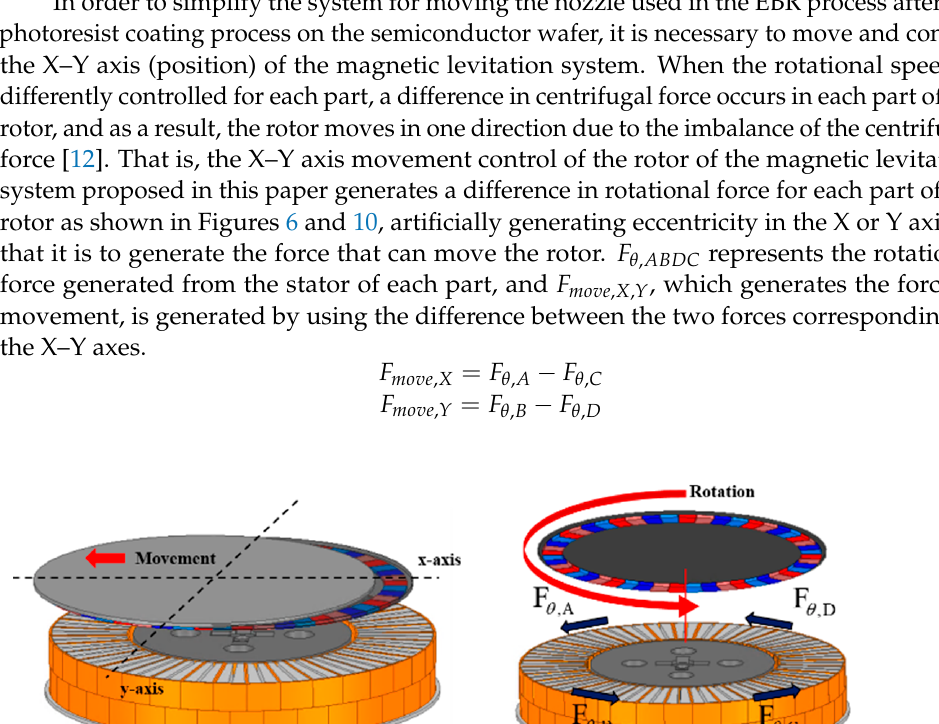
Figure 10. Principle of X–Y axis movement. 3.6. Method of Rotation and X–Y Axis Movement Sensing Using Non-Contact Encoders Non-contact encoders that use the method of sensing the encoder scale attached to the rotor have a limited sensing range for the X–Y axis. However, even if changes (errors)